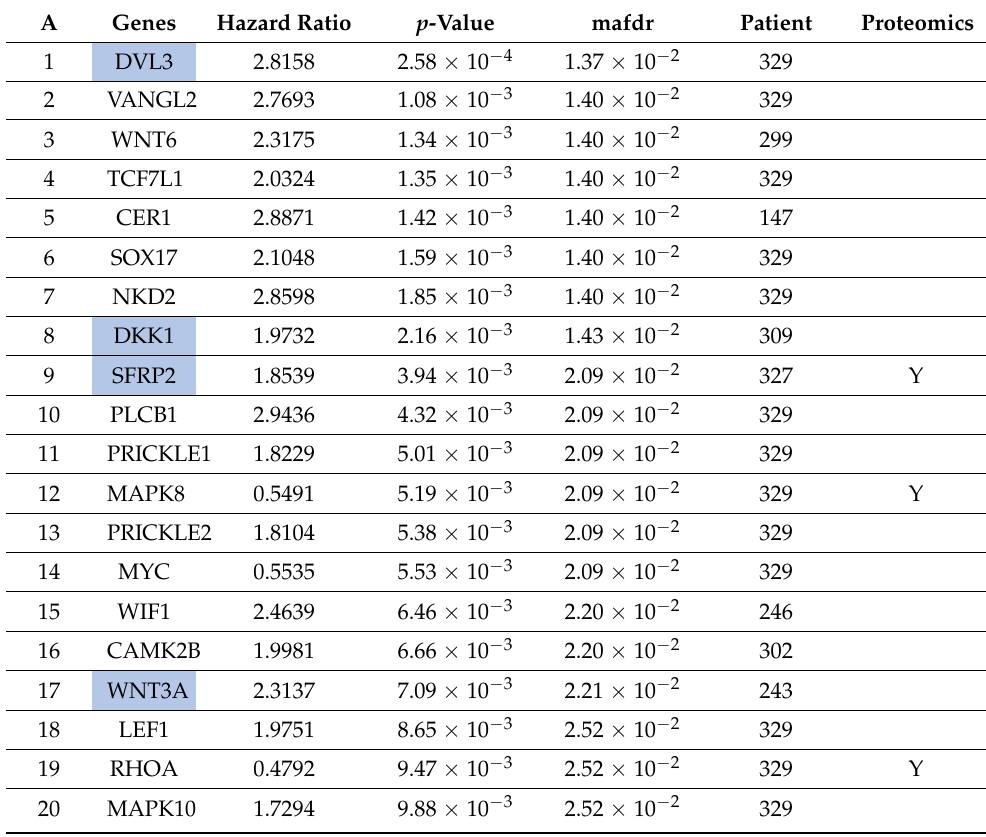
Table 4. Significant genes and proteins in the WNT signalling pathway from TCGA legacy datasets. ( A ) List of significant genes and their associated hazard ratio, p -value, and mafdr (estimate positive false discovery rate for multiple hypothesis testing). Hazard ratios smaller than one (between 0 and 1) indicate a negative association (decreased risk), hazard ratios of >1 indicate a positive association (increased risk). The last column, proteomics, indicates whether proteomics data for this gene